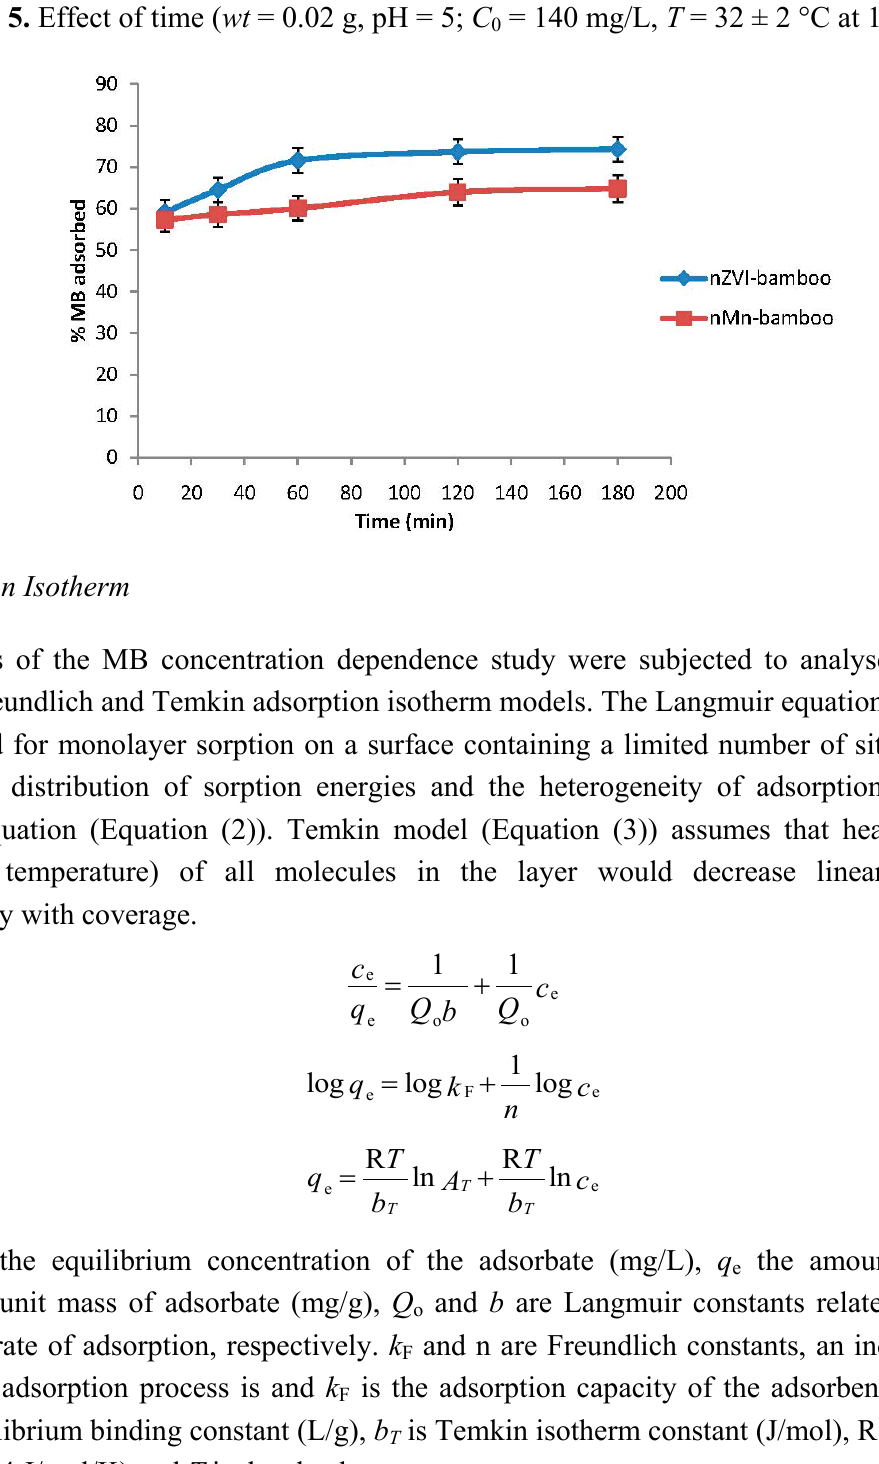
Figure 5. Effect of time ( wt = 0.02 g, pH = 5; C